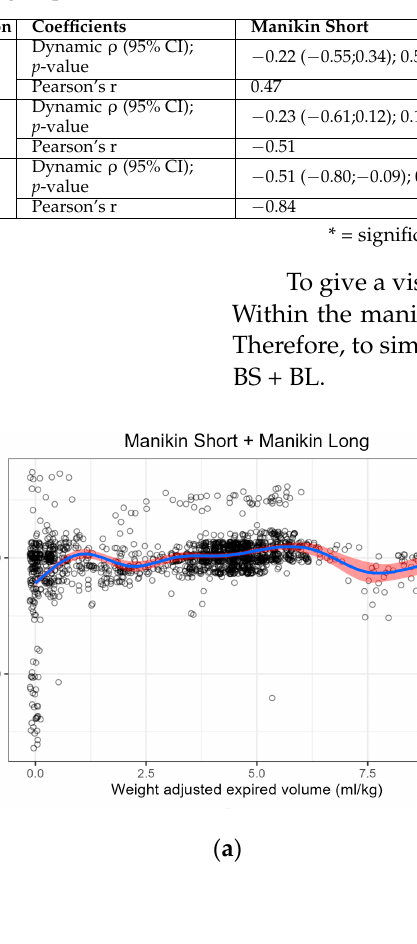
Table 2. Dynamical correlation and Pearson correlation coefficients for pairwise relationships of PIP- eV T -leak for the four groups.